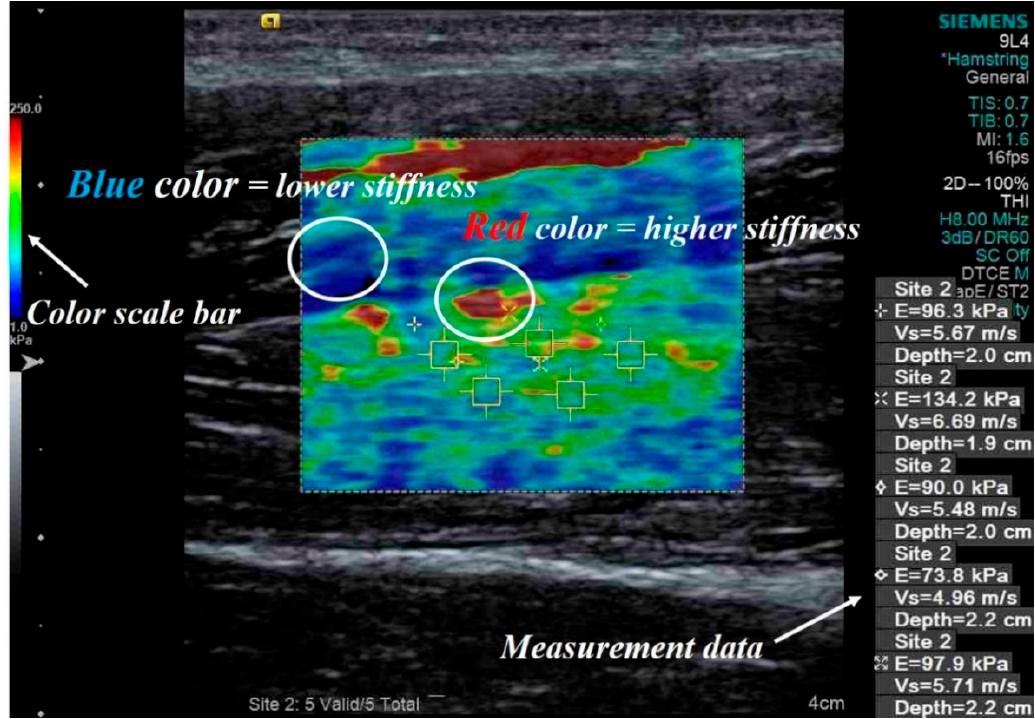
Figure 1. Example of a shear wave elastography image including quantitative measurement data expressed in kPa and m/s for a hamstring. The yellow box indicates the region of interest observed in the shear wave elastography image, and the white circles indicate the intensity of the stiffness expressed in blue and red colors.